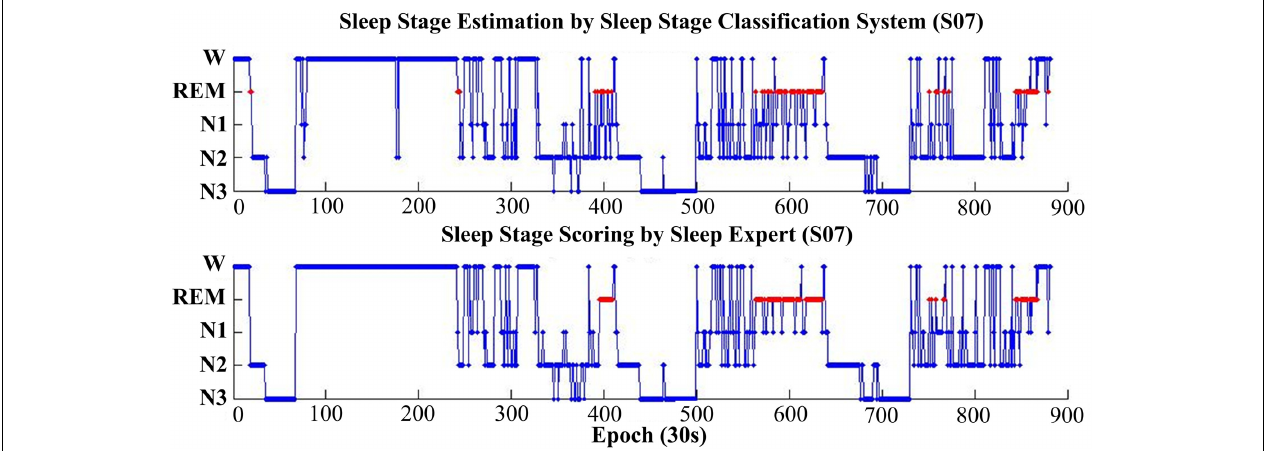
FIGURE 7 | Hypnograms obtained from the proposed sleep stage classification system (top plot) and the sleep expert with manual scoring rules (bottom plot). For this subject (S07), the overall accuracy is 82.5% (kappa